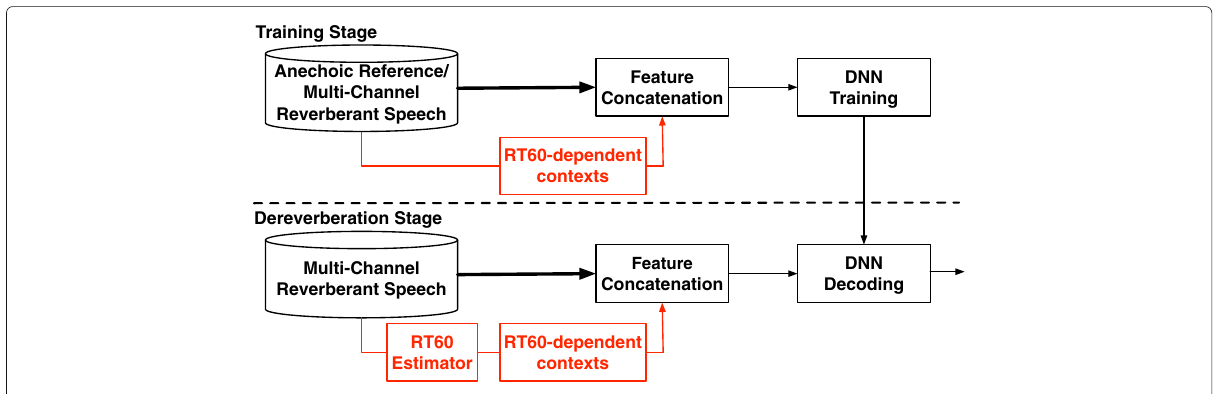
Fig. 5 A block diagram of the proposed RTA-DNNSpatial system